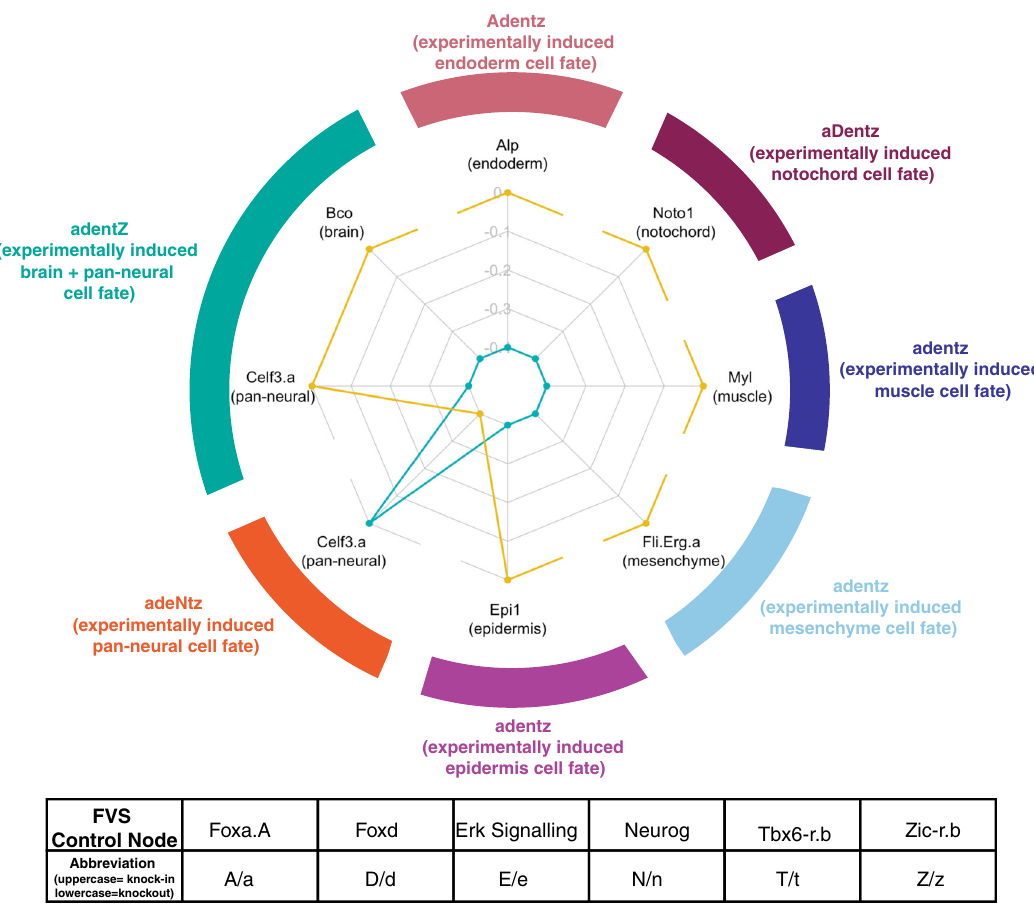
Fig. 4 SFA simulations of perturbations on FVS control nodes for cell fate speci fi cation in ascidian embryos. Kobayashi et al. 55 performed experimental combinations of perturbations on FVS control nodes to induce seven tissue fates in ascidian embryos. We aimed to reproduce these results in silico by simulating the combinations of perturbations on FVS control nodes using SFA. The results of each combination of perturbations are displayed in the radar plot. Each axis on the radar plot displays the expression value for an internal-marker node, with the tissue each internal-marker node represents in parentheses. The teal polygon shows the expression values of the internal-marker nodes in the attractor associated with the unperturbed state. The yellow polygon displays the internal-marker node attractor state expression values produced by applying one combination of perturbations on FVS control nodes to the unperturbed initial state. Note that the precise steady- state values have been scaled for plotting, and the raw data can be found in Supplementary Table 3. The outer colored ring denotes the combination of perturbations on FVS control nodes performed with the respective results displayed at that axis. The tissue fate that was induced experimentally by a perturbation is denoted in parentheses. Each letter and capitalization stand for a separate FVS control node and its perturbed state, as described in the table at the bottom. For a simulation of the perturbations on FVS control nodes to be considered successful, the expression value of the internal-marker node must be greater in the attractor produced by the perturbation on the FVS control nodes than the expression value in the attractor associated with the unperturbed state (the yellow polygon extends out past the teal polygon on the radar plot). We reproduced the cell fate speci fi cation results for 6/7 cell fates, excluding adentZ inducing the pan-neural cell the development of adaptive resistance via inhibition of ERK (MAPK1), a member of the MAPK signaling pathway. This result was validated experimentally in HT29 CRC cells. Therefore, with only the CRC signal pathway network structure, RNA-seq data from untreated HT29 cells, and functionally annotated mutational information as input to NETISCE, we sought to identify perturba- tions on FVS control nodes in combination with BRAFi that overcome adaptive resistance to MAPKi therapy (Fig. 7a). Park and colleagues built a CRC signaling network containing 95 nodes and 337 edges (Fig. 7b). We adapted the PROFILE method 60 to verify that the generic CRC network and our SFA simulations preserved the phenotypic signatures of apoptosis and prolifera- tion (see Supplementary Text 5 and Supplementary Fig. 4). The normalized gene expression data from an untreated HT29 sample was used for the initial activities for all SFA simulations, as data for HT29 cells with BRAFi and BRAFi + EGFRi treatment is unavailable. In HT29 cells, PIK3CA and BRAF have